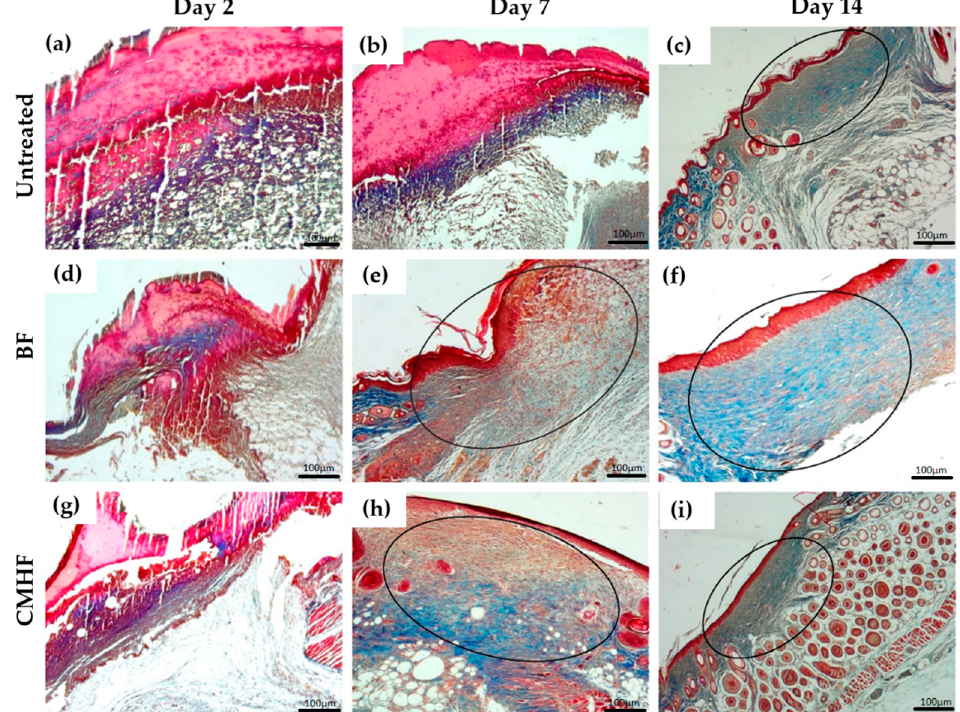
Figure 10. Photomicrographs of Masson’s trichrome-stained tissue fragments from the untreated, BF, and CMHF, where collagen deposition was assessed ( a , d , g ) two days after wound infliction, ( b , e , h ) seven days after wound infliction, and ( c , f , i ) 14 days after wound infliction. Ten different fields were observed with magnifications of 10 × and 40 × near the skin lesion for collagen fiber deposition at different healing stages.